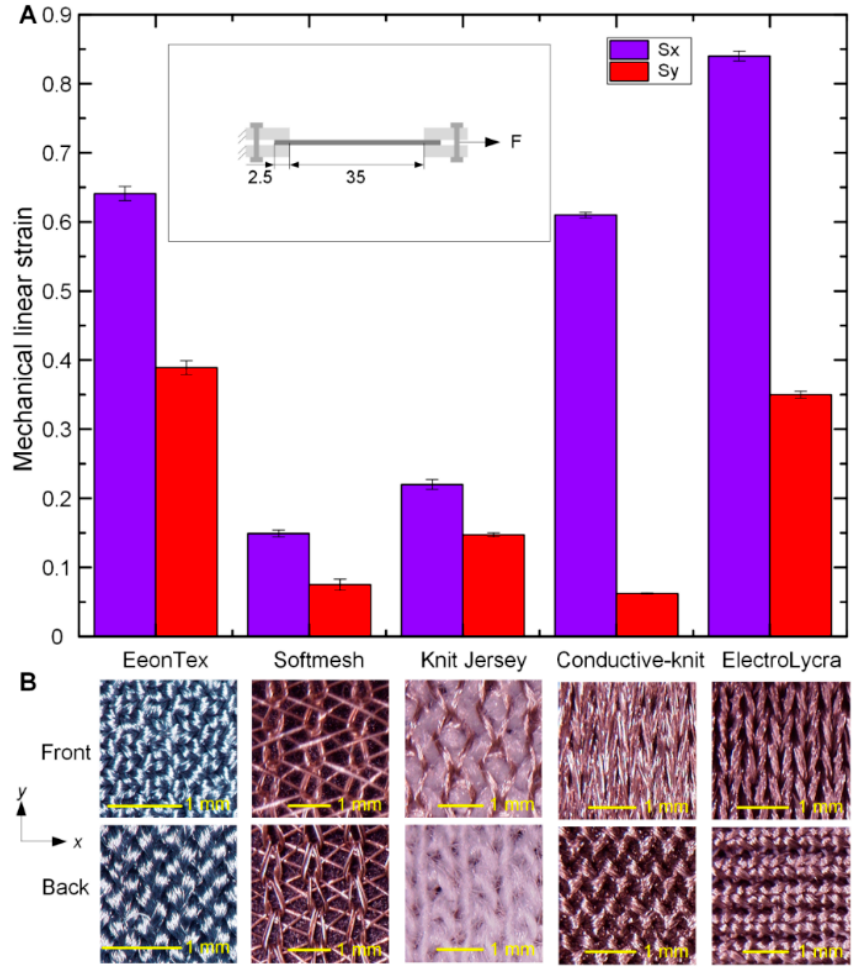
Figure 2. Comparison of the five e-textiles in terms of mechanical strains and microscopic structures. ( A ) Comparison of mechanical strains in x and y axes for the five conductive textiles under 20 N tensile force. Inset shows the schematic diagram of the test setup. ( B ) Micrograph images of the patterns for each textile from both sides.